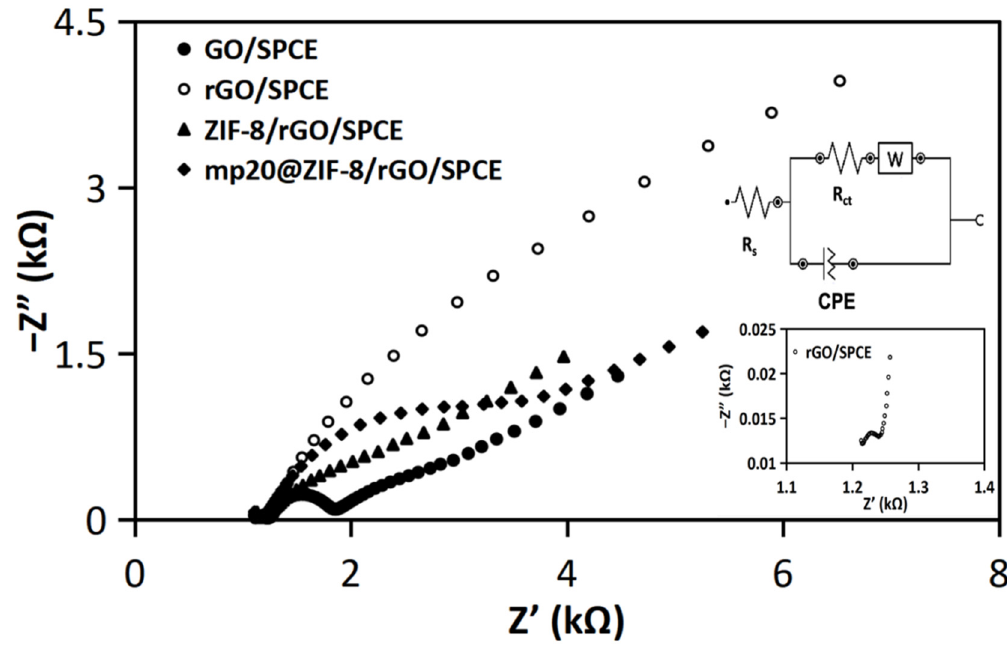
Figure 4. Nyquist plots of modified SPCEs in 5 mM Fe(CN) 63 − /4 − in presence of 0.1 M KCl solution. The frequency range is 1 Hz to 100 kHz, and the amplitude is 0.2 V. The inset shows a magnification Nyquist plot of rGO/SPCE (below) and Randles equivalent circuit applied to fit the data (above).